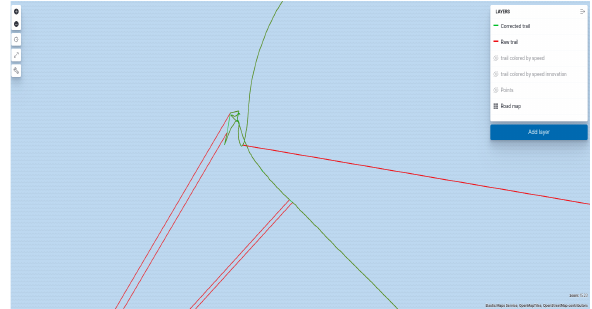
Figure 1 . Examples of boat positions identified as outliers (red) and normal (green). The red lines illustrate the "jumps" generated by the GPS